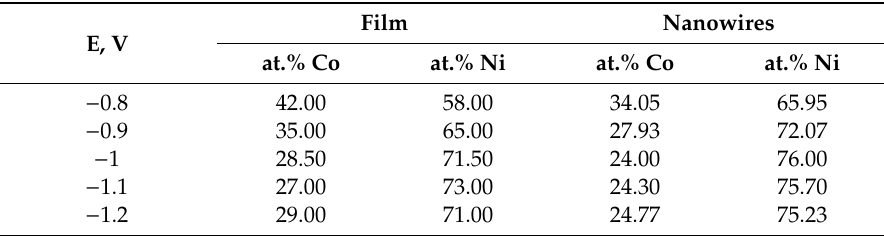
Table 1. Composition of the deposits obtained at di ff erent applied potentials. Film E, V